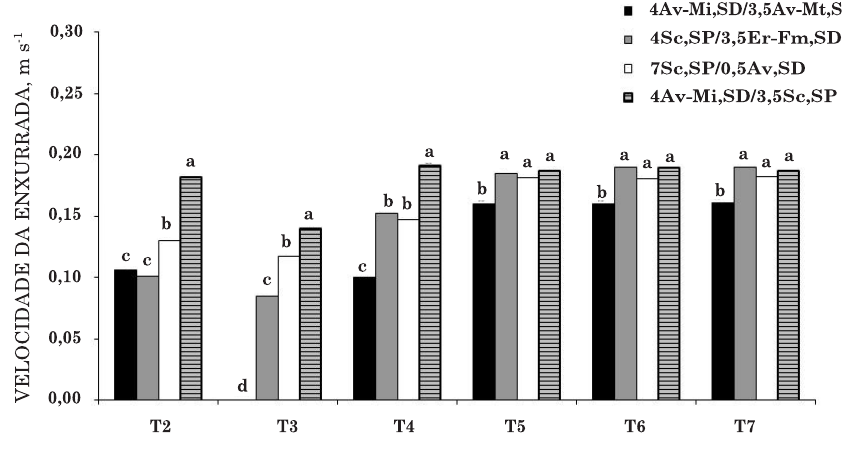
Figura 4. Velocidade da enxurrada na sua condição de equilíbrio, nos testes de erosão com chuva simulada (condição superficial nos testes: T1=solo não mobilizado e completamente coberto; T2=solo não mobilizado e descoberto; T3 a T7=solo sucessivamente mobilizado com grade leve e descoberto) nas sequências culturais estudadas (valores médios de duas repetições por tratamento). Colunas sobrepostas com a mesma letra, no mesmo teste de chuva, não diferem estatisticamente entre si (Duncan, p <